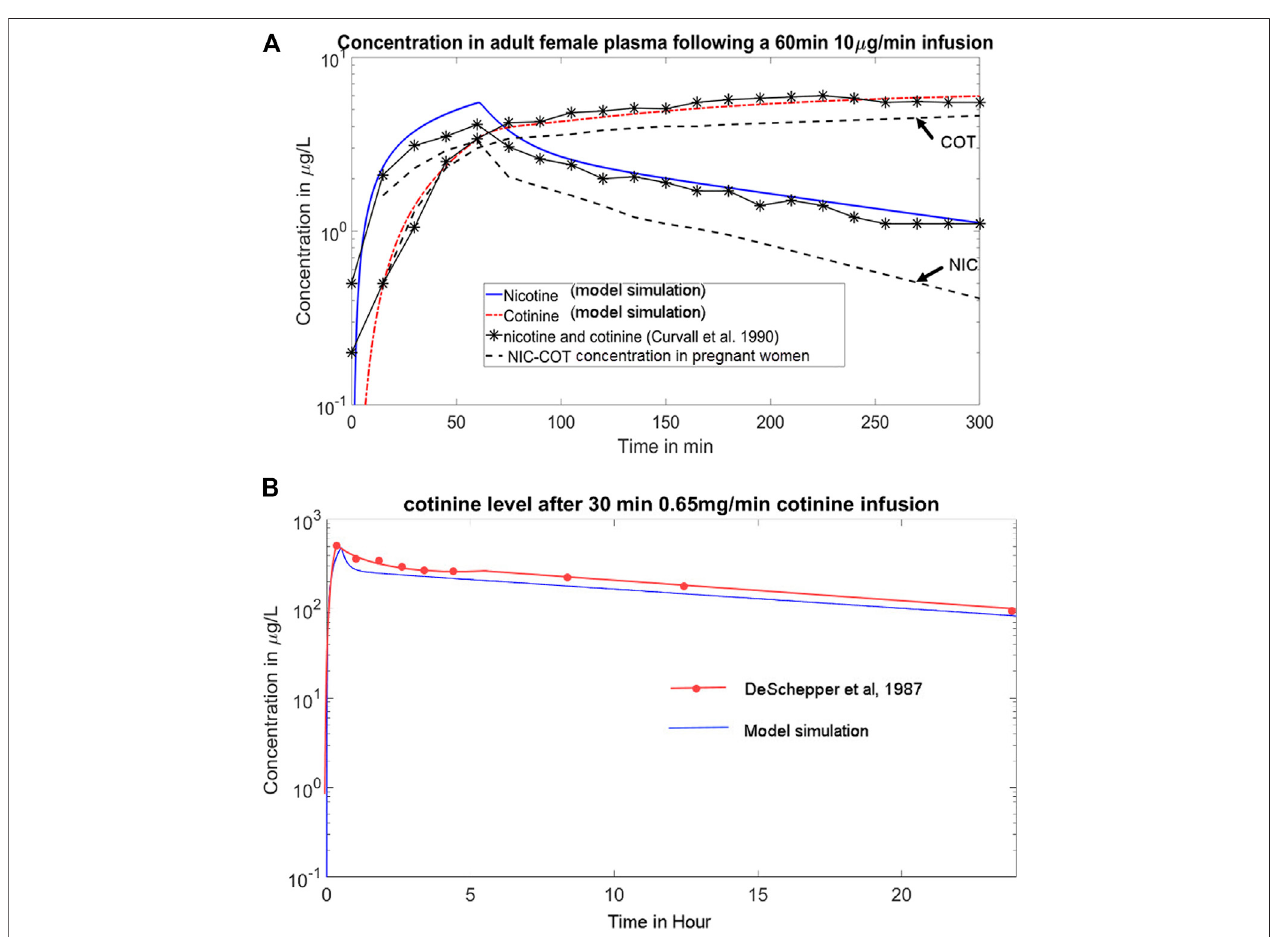
FIGURE 2 | (A) Simulations of the time course of the plasma concentrations of NIC/COT following a 60 min 10 μ g/min intravenous infusion of nicotine, per data fromCurvalletal.(1990).ThebluesolidlineandreddottedlinerepresenttheNIC-COTconcentrationinadultmen,matchingexperimentaldata(solidlineswithasterisks), which the dashed lines represent plasma concentration of NIC-COT in pregnant women showing higher clearance rates; (B) Simulation of the cotinine level after 30 min of 0.65 mg/min continine infusion, per data from De Schepper et al. (1987). The blue line represents model simulation.